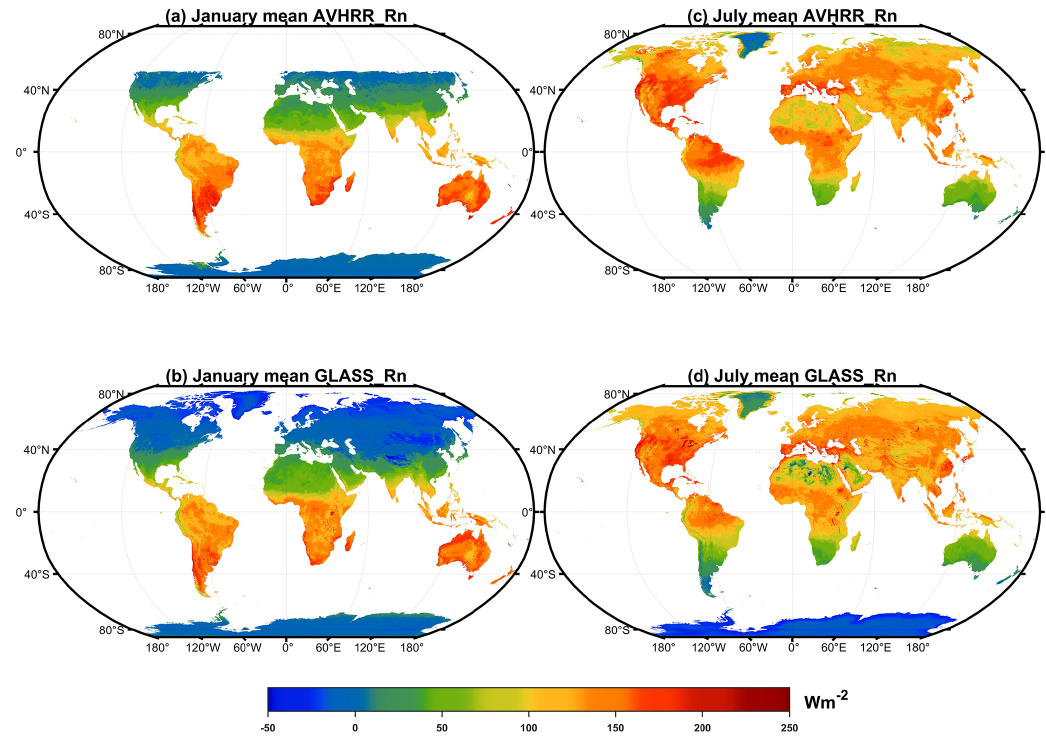
Figure 10. Spatial distribution of monthly mean AVHRR and GLASS R n retrievals in January (a, b) and July (c, d) 2008.